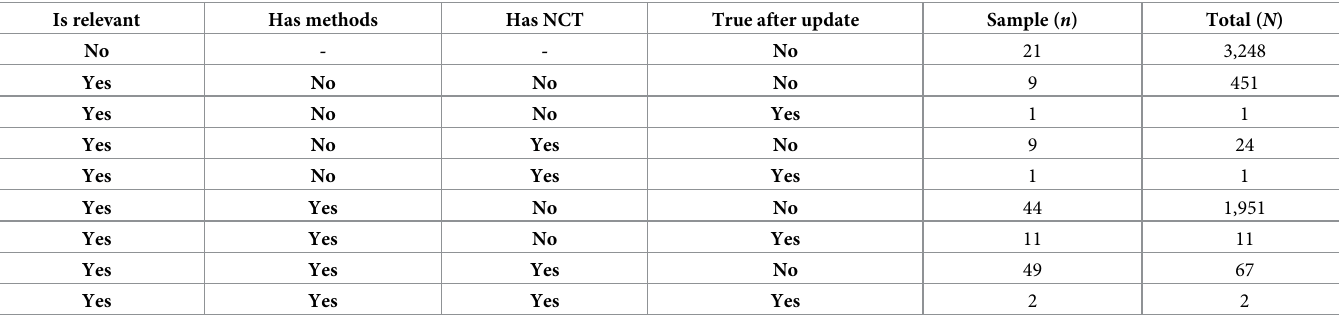
Table 3. Number of articles sampled out of 5,756 predicted negative for protocol registration across strata of subcategorizations. Is